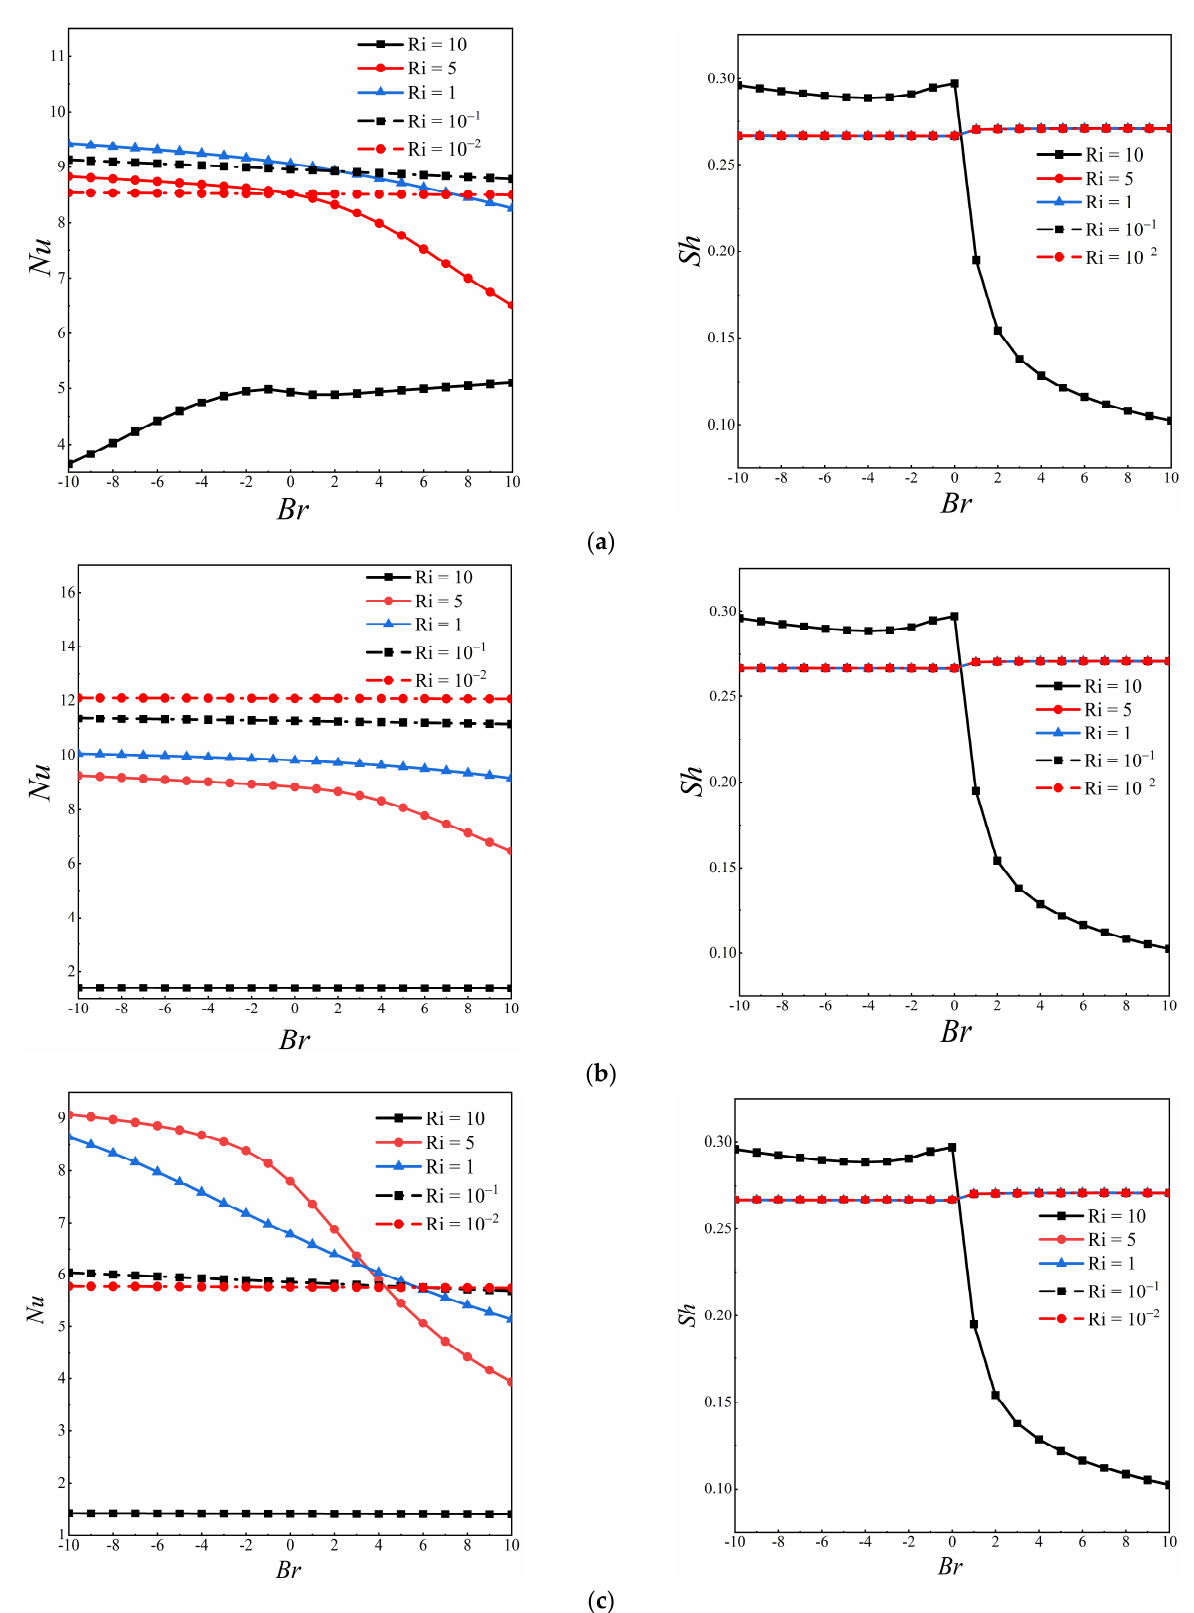
Figure 9. The effect of porous ‐ fluid thermal conductivity ratio and buoyancy ratio on heat and mois ‐ ture transfer for three types of porous media arrangement at Kr = 1, Kc = 1, and Da = 10 − 3 . ( a ) Type A, ( b ) Type B, and ( c ) Type C.